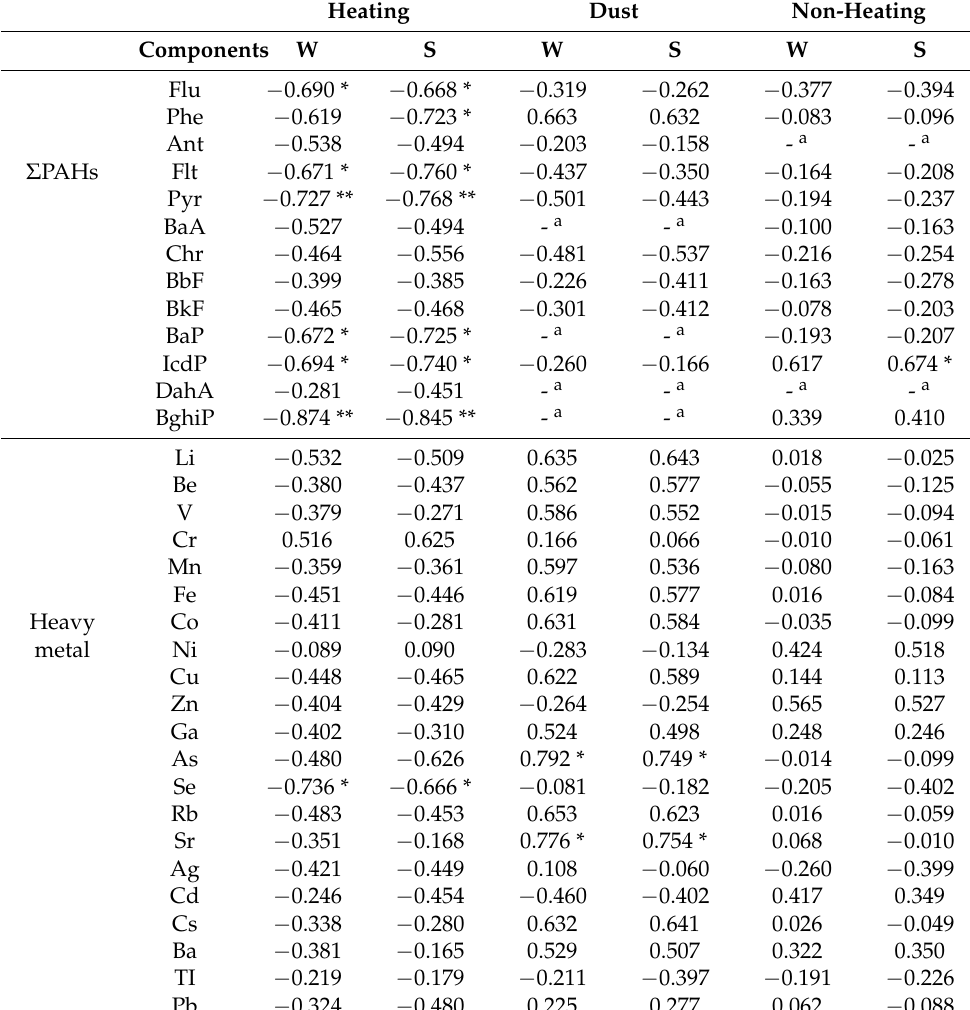
Table 1. Spearman’s rank correlation coefficients (r) between TD 30 values and PM 2.5